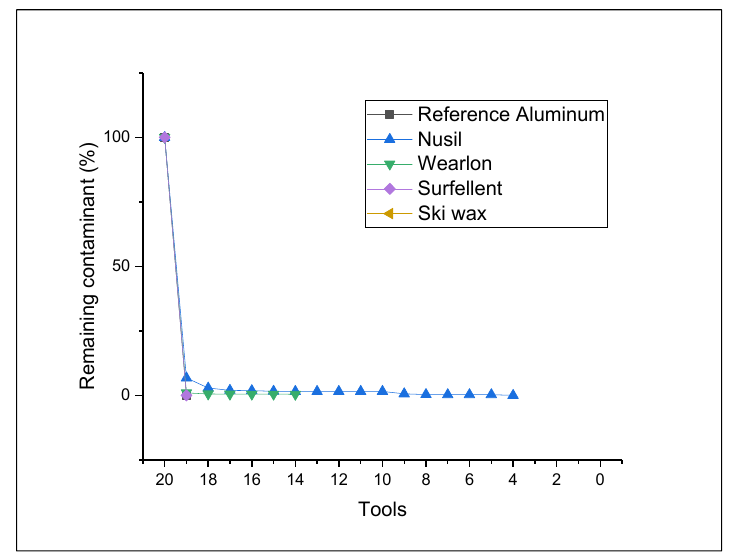
Figure 11. Multi-tool analysis under dry snow. Note: Numbers correspond to the tool used and number of passages during de-icing. Where “20 to 16” represent the broom, “15 to 11” represent the soft polymer blade, “10 to 6” represent the squeegee, and “6 to 1” represent the hard polymer blade.